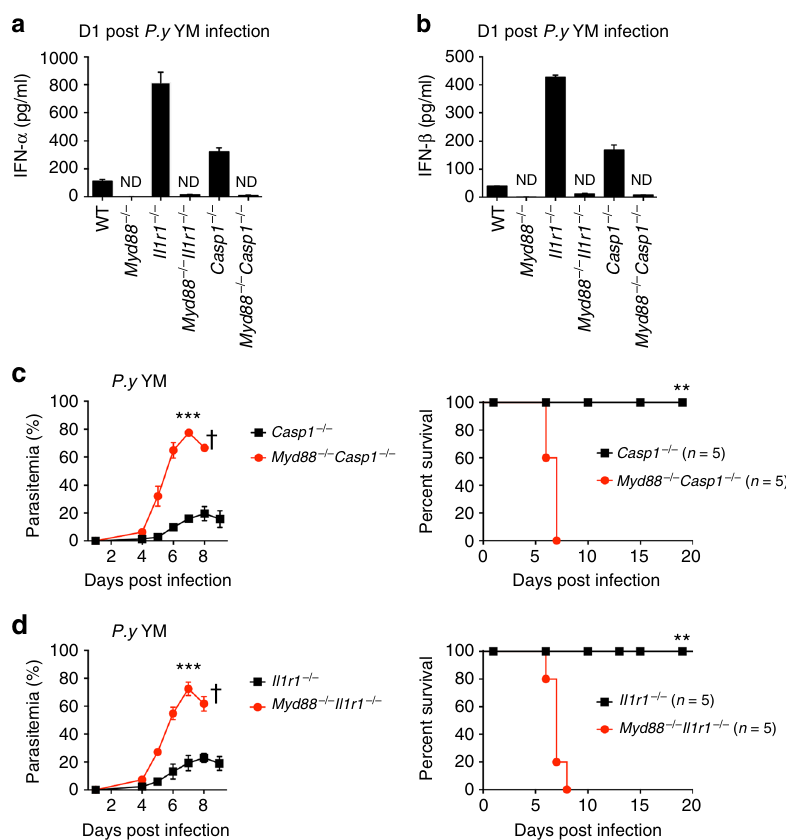
Fig. 4 Activation of in fl ammasome negatively regulates type I IFN cytokine production in a MyD88-dependent manner. WT, Myd88 − / − , Il1r1 − / − , Casp1 − / − , Myd88 − / − Il1r1 − / − , and Myd88 − / − Casp1 − / − mice ( n = 5) were intraperitoneally infected with P. yoelii YM. Serum was collected at 24 h post infection and subjected to ELISA analysis of IFN- α ( a ) and IFN- β ( b ). Parasitemias and survivals ( c and d ) were monitored daily. Data are representatives of three independent experiments with similar results and plotted as mean ± SD. ** p < 0.01, *** p < 0.001 vs. corresponding control. ND, not detected.